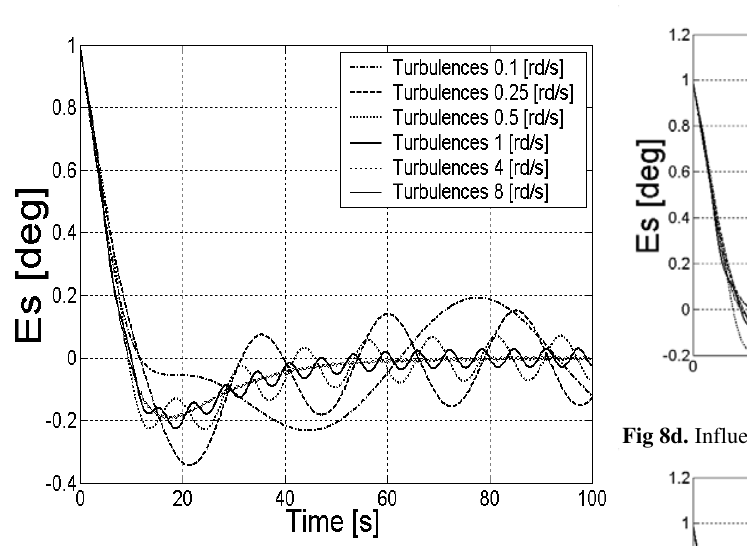
Fig 8a. Influence of turbulence with the use of PID controller